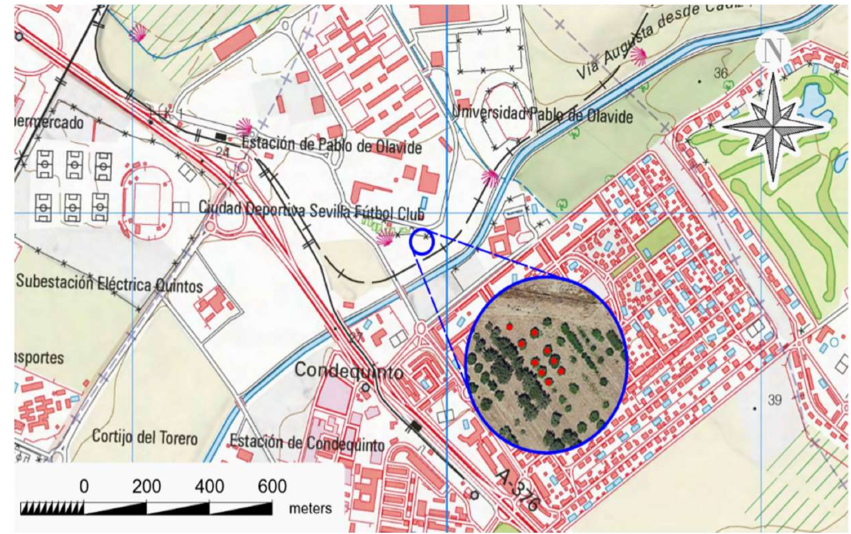
Figure 3. Location of the trials at the University of Sevilla